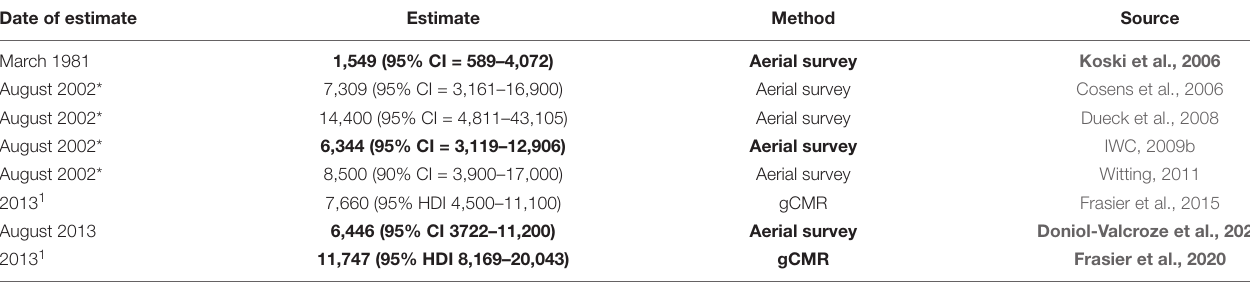
TABLE 1 | Abundance estimates of the ECWG bowhead whale stock using data that covered most of the range of the